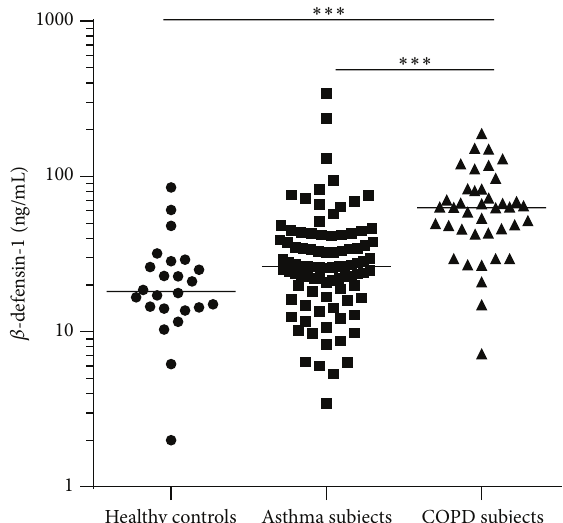
Figure1: 𝛽 -defensin-1inairwaydisease.Theairwayexpressionof 𝛽 - defensin-1 protein is elevated in participants with COPD compared to asthma patients and healthy controls (Kruskal-Wallis test; 𝑝 < 0.001 ). The bars represent the median of each group. ∗∗∗ Dunn’s post hoc testing 𝑝 < 0.001